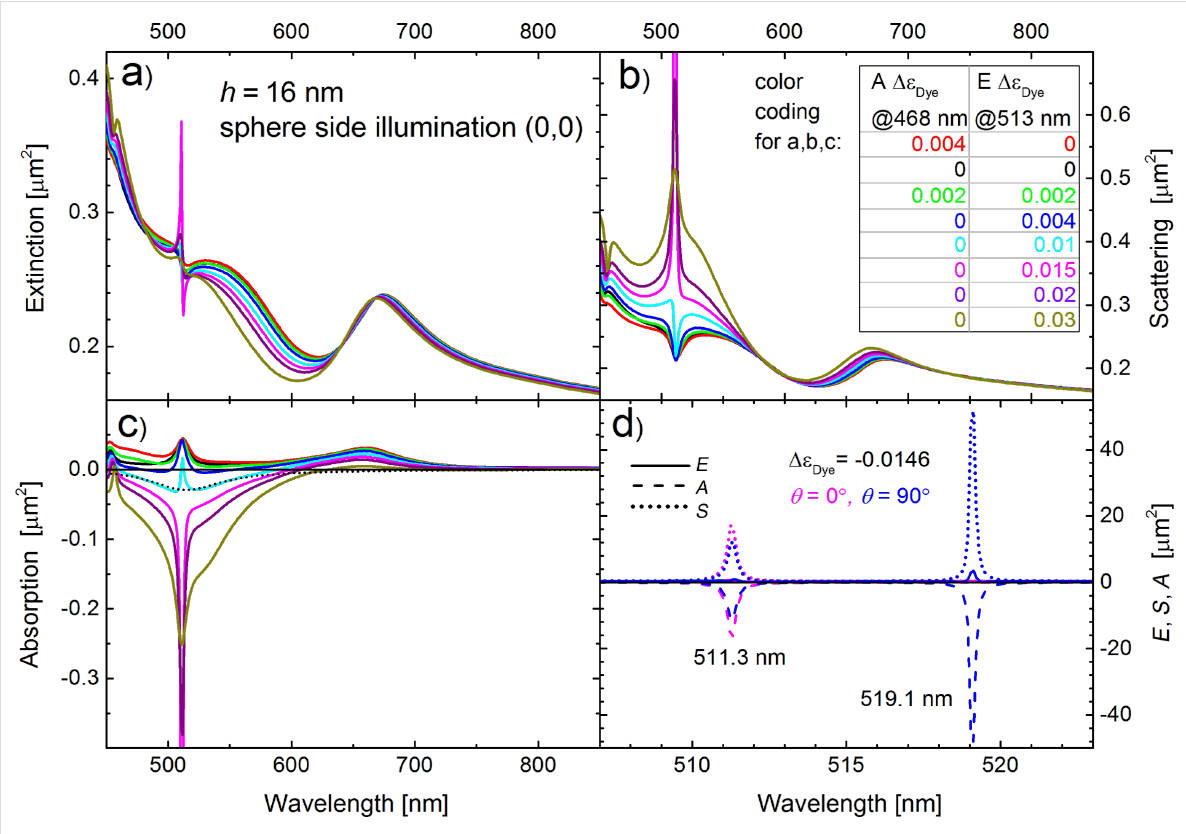
Figure 6: Approach to lasing for a semi-shell thickness of h = 16 nm. Parameters and order of panels a,b,c are the same as in Figure 2. The strengths of the absorption and the gain (cf. Equation 1) are color-coded as shown in the inset of (b). The dimensionless Im( ε Sphere ) is shown in (c) by the dotted curve. Panel (d) shows a zoom of the extinction (solid curves), scattering (dotted) and absorption (dashed) spectra near the lasing threshold ( Δε Dye = 0.0146, A = 0, E = 1) close to the l = 2 resonance. The magenta lines refer to the sphere side irradiation (0,0), while the blue lines are calcu- lated for an illumination from the x-direction ( θ = 90°, φ = 0°) so that the incident light is polarized in axial z-direction. In this case a second resonance appears near 519 nm, in addition to the resonance near 511 nm, which exists for both